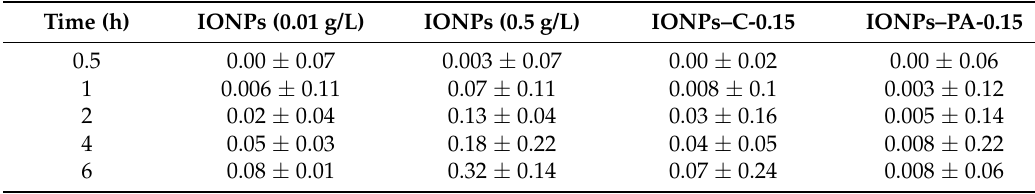
Table 5. Ion release from adsorbents at different time intervals (mg/L).